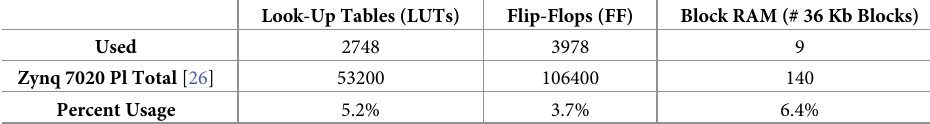
Table 2. Resource utilization of the Zynq 7020 PL for this design.